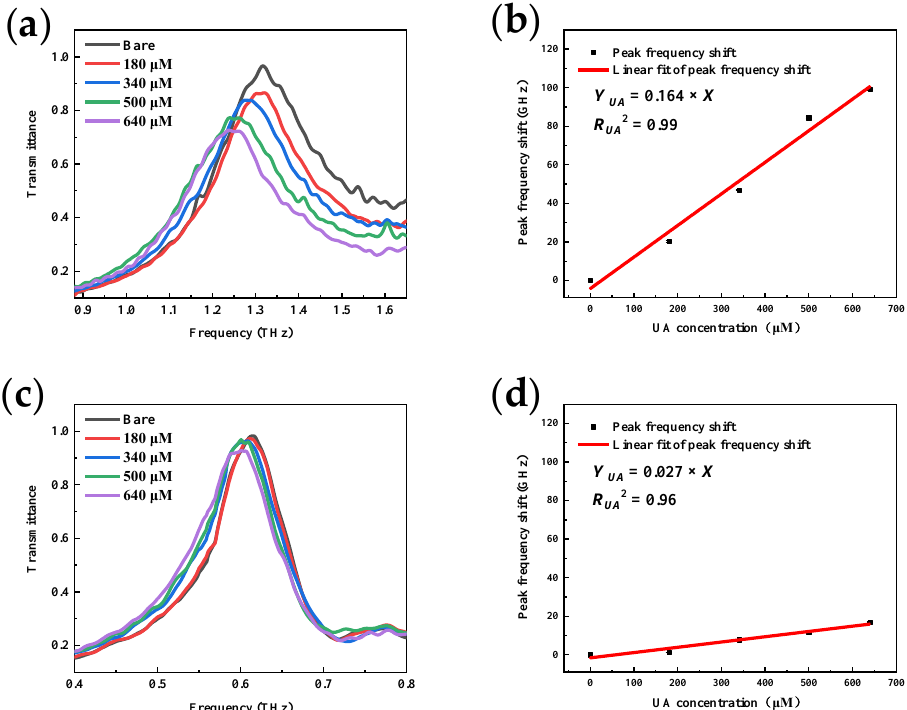
Figure 8. Detection results of different sensors with the same analyte: ( a ) HF peak shift with UA; ( b ) HF sensor calibration curve in UA detection; ( c ) LF peak shift with UA; ( d ) HF sensor calibration curve in UA detection.